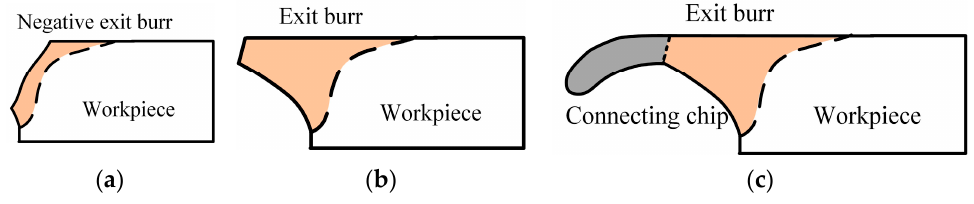
Figure 4. Three different cases of exit burr formation. ( a ) Negative burr. ( b ) Common exit chip. ( c ) Chip connecting with exit burr.